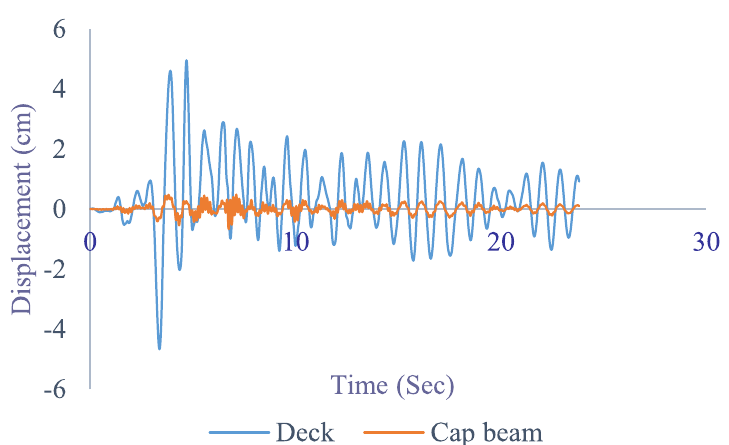
Fig. 17 The lateral displacement of points Deck and Cap beam in the longitudinal direction (X) in model 3 under the Tabas earthquake